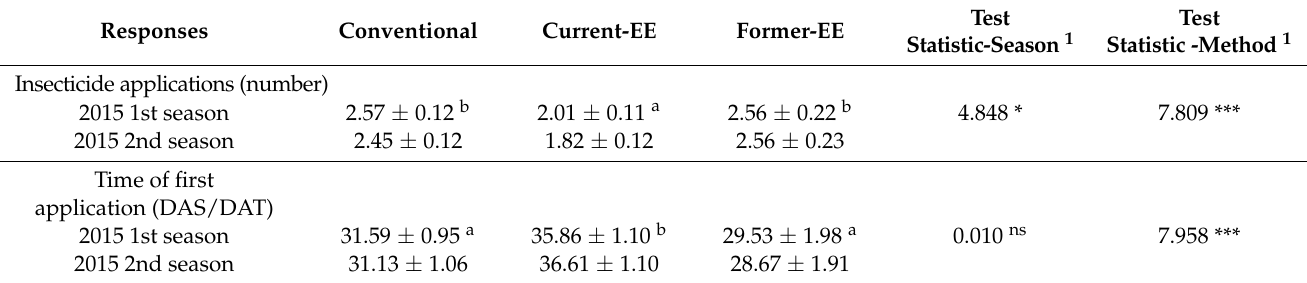
Table 4. Information from farmer surveys related to insecticide applications to rice crops and reported grain